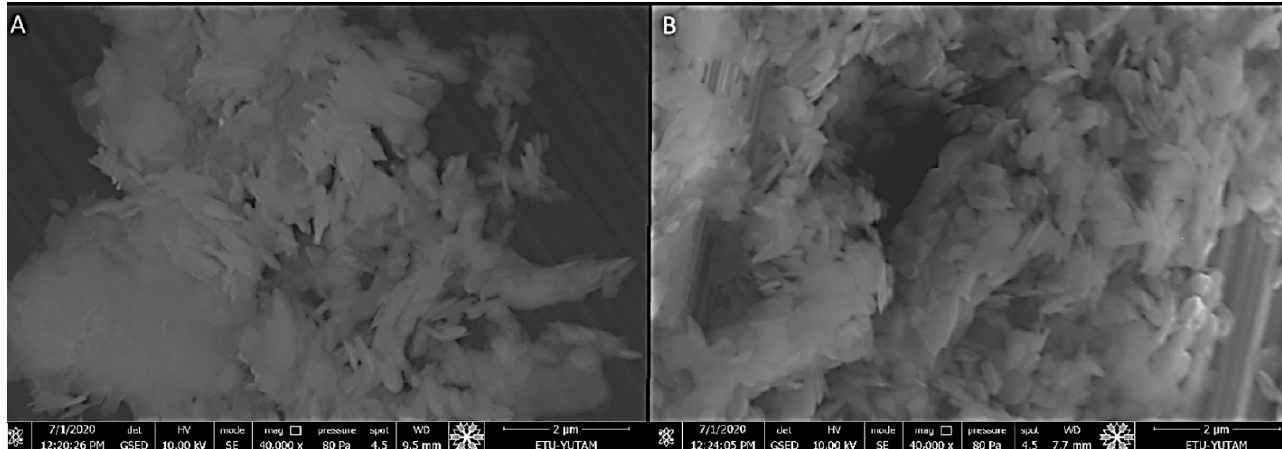
Figure 1. SEM image: ( A ) hBN; and ( B ) hBN-FA.